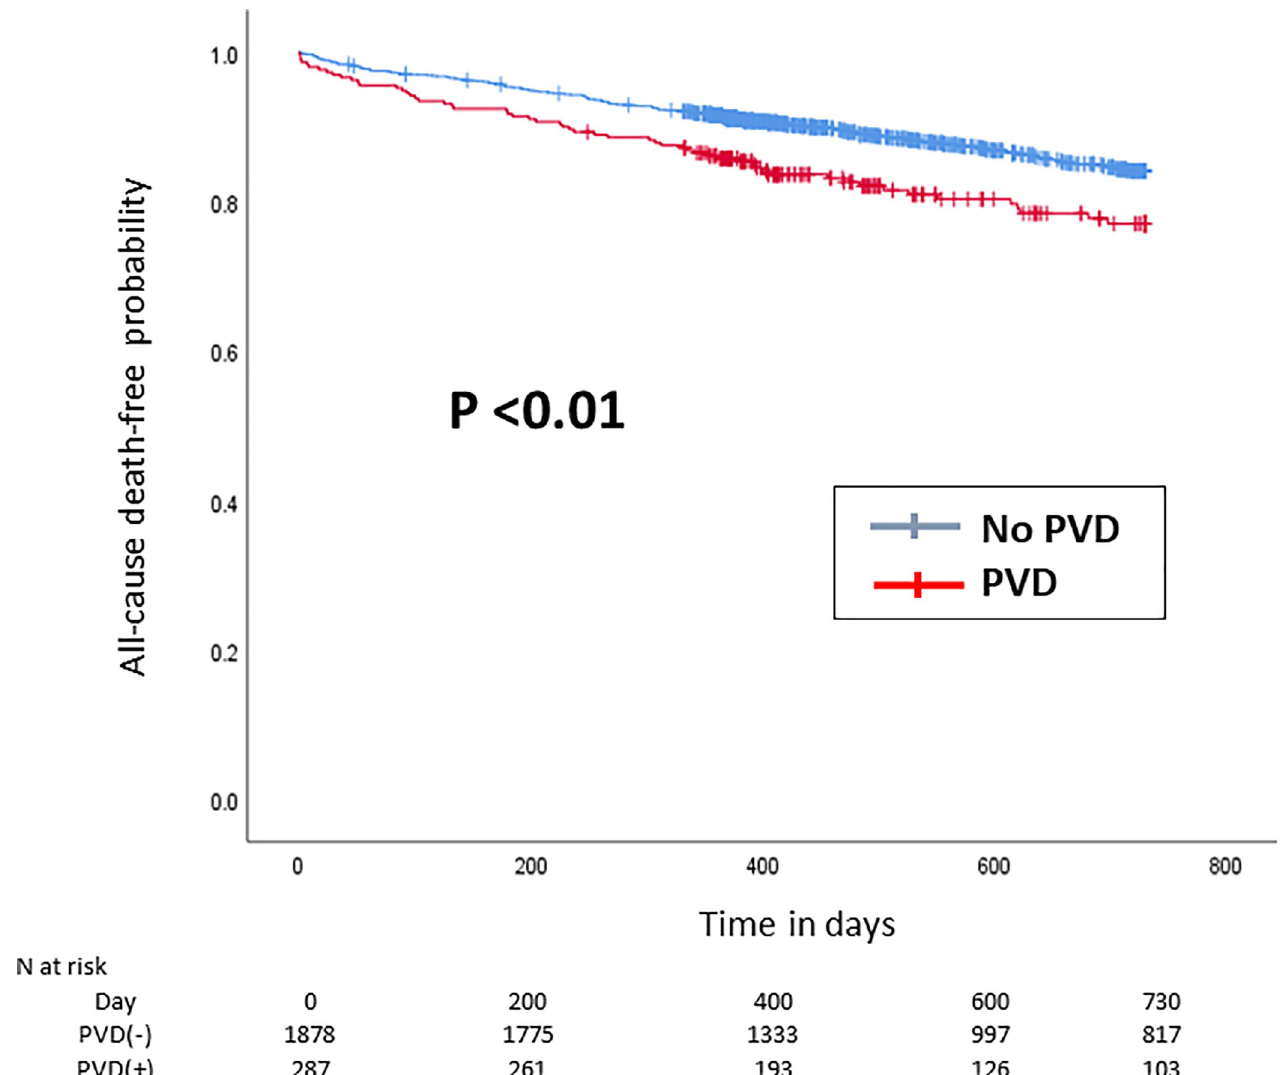
Fig 2. Kaplan–Meier curve of the 2-year (A) all-cause death-free rate. Red and blue lines indicate patients with and without PVD patients, respectively. PVD = polyvascular disease.